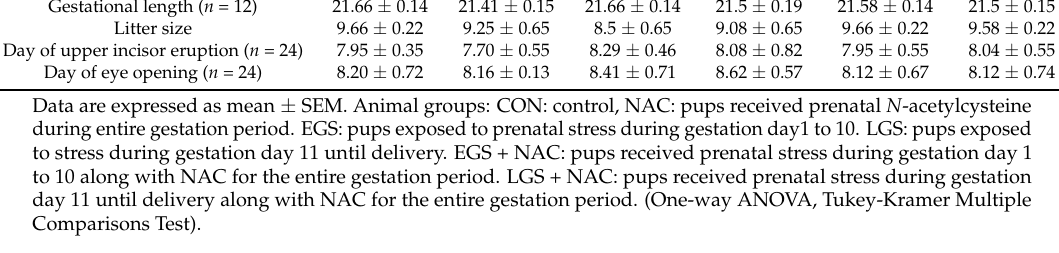
Table 2. Effect of early or late gestational stress and prenatal NAC treatment on the mortality rate. Animal Groups